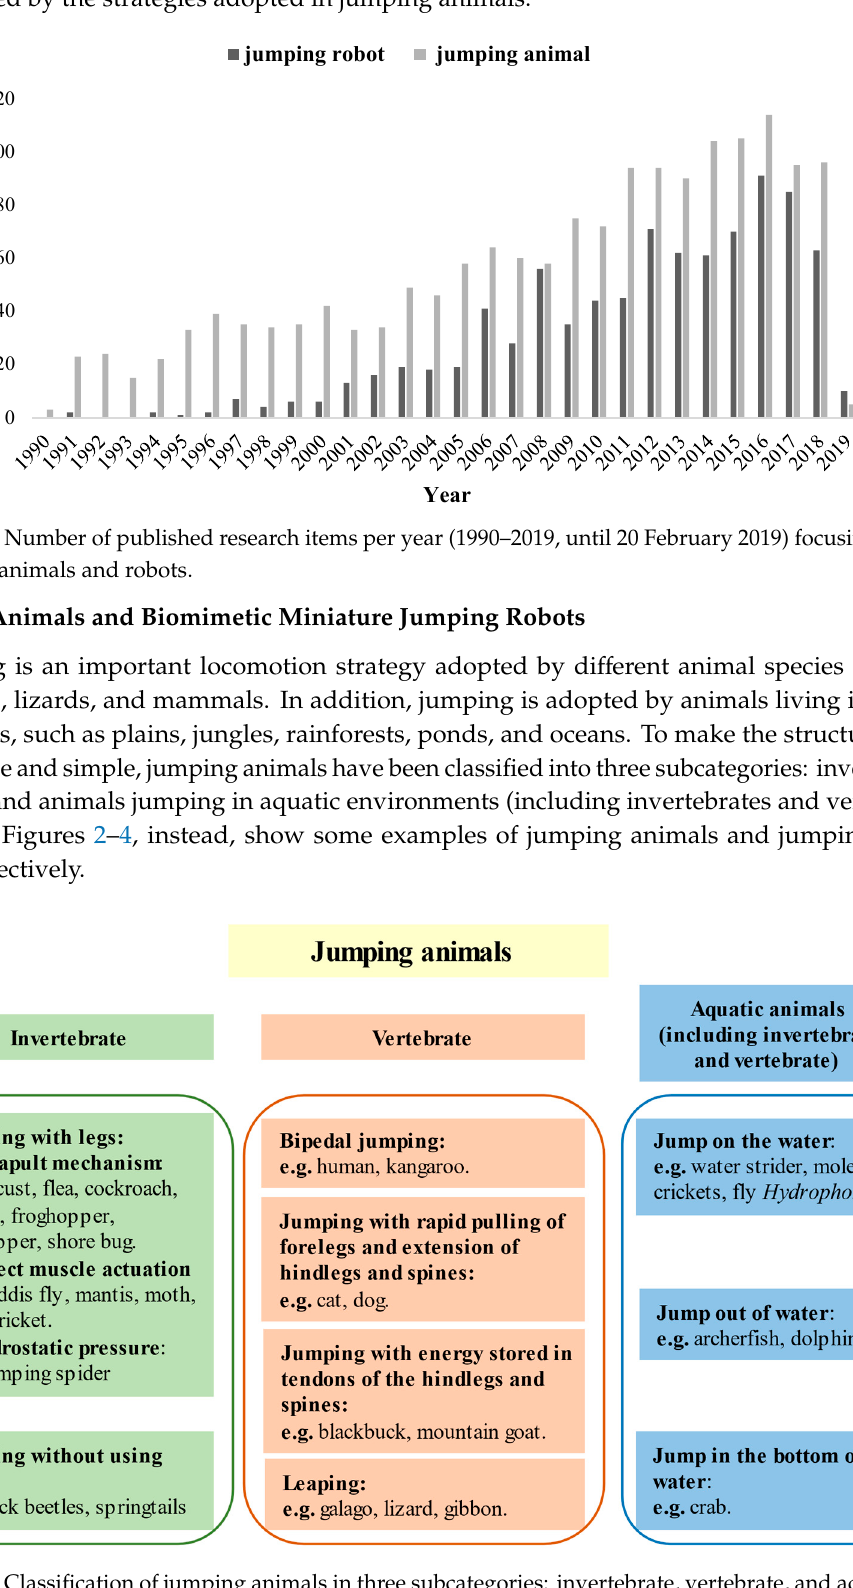
Figure 3. Jumping animals ranging with body size [38]: ( a ) kangaroo; ( b ) rabbit; ( c ) frog; ( d ) cricket; ( e ) leafhopper; ( f ) flea. ( a ) ( b ) ( c ) Figure 4. Examples of jumping robots: ( a ) Multi ‐ legged underwater robot [39]; ( b ) Leafhopper ‐ inspired jumping robot [38,40]; ( c ) Bionic ‐ Kangaroo [41].